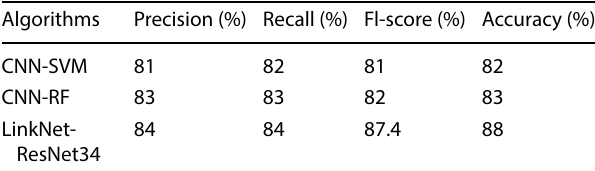
Table 5 Comparison of models on test data Algorithms